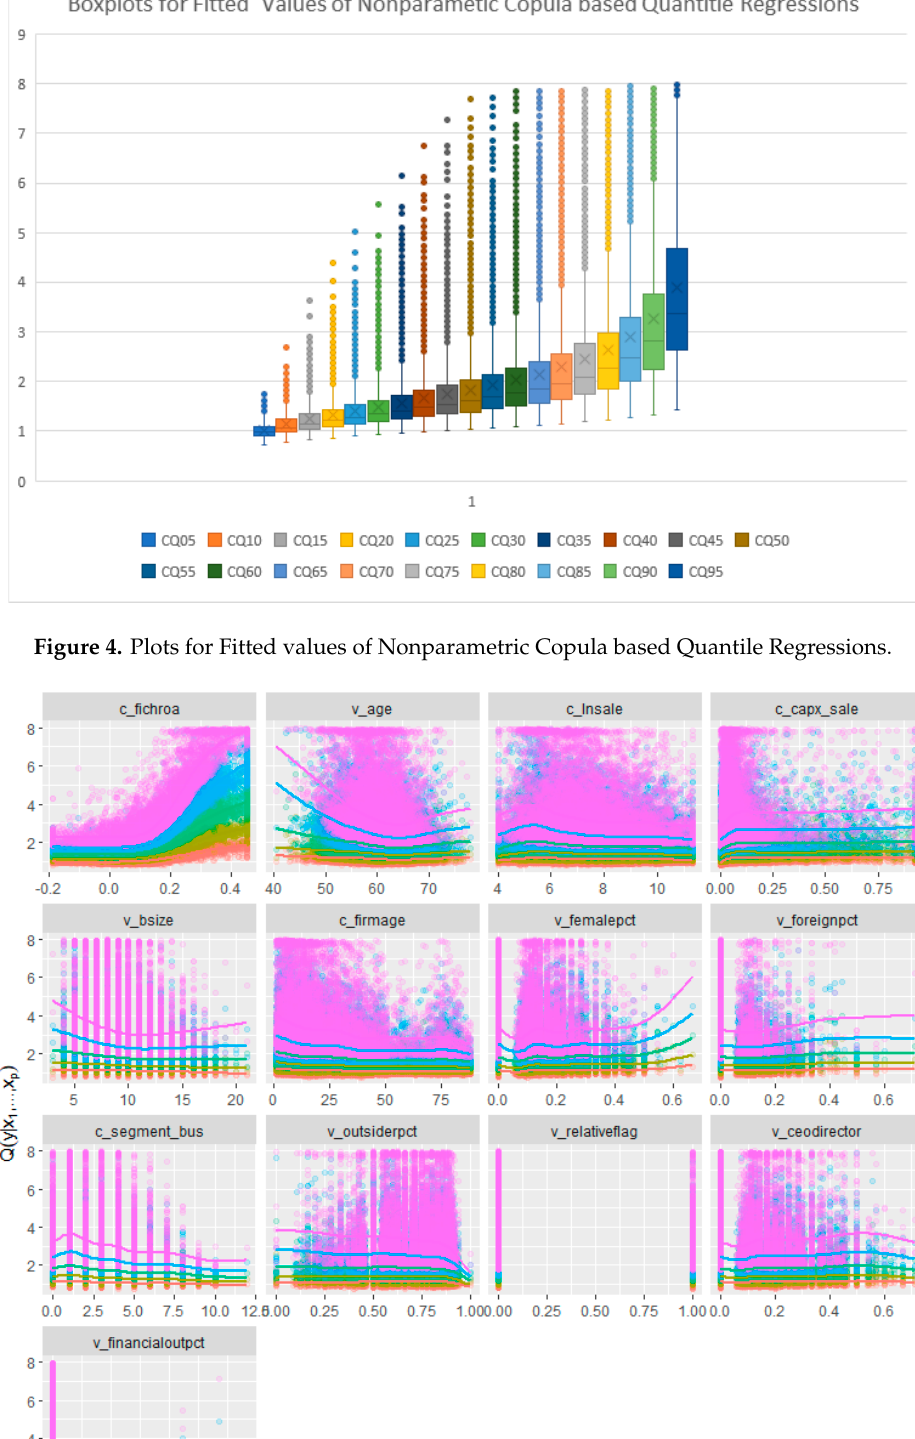
Figure 3. Plots for Fitted values of Copula based Quantile Regressions (Parametric).